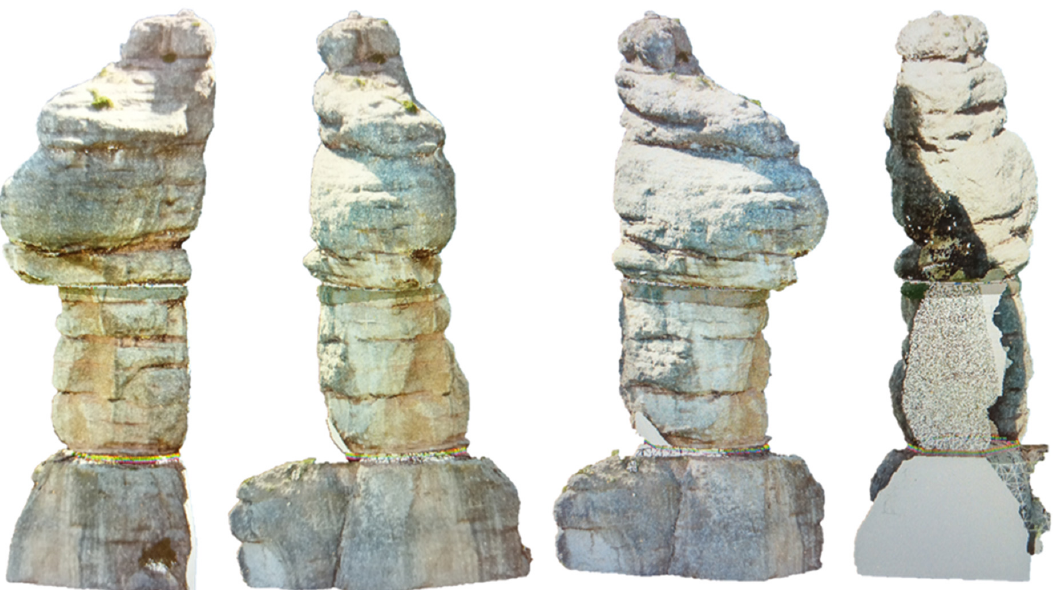
Figure 20. Montserrat: West, North, East and South 2D views of the “Cadireta” 3D model, prior to the FEM mesh generation. Note in the picture on the right (partially hidden side) the planes added to the surface of the base of the column to close the volume.